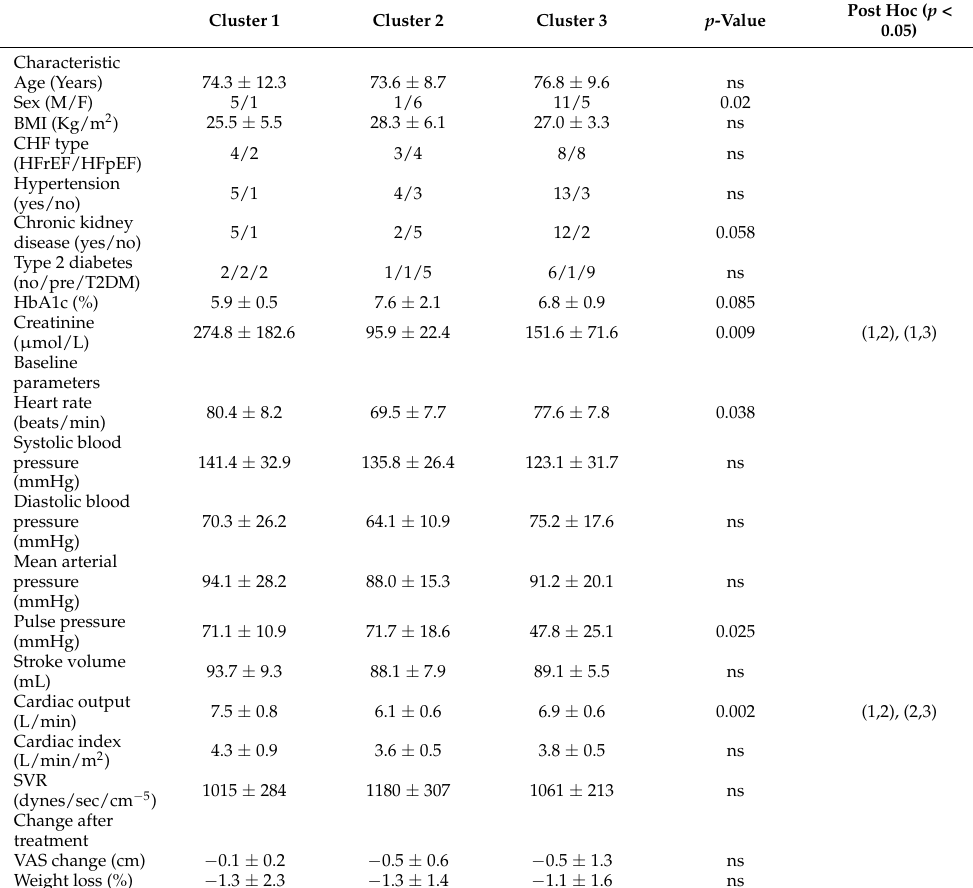
Table 2. Baseline characteristics between clusters (Ratios or mean ± SD). SVR—systemic vascular resistance; BMI—body mass index; SpO 2 —blood oxygen saturation; ns—not significant; HFrEF— heart failure with reduced ejection fraction; HFpEF—heart failure with preserved ejection fraction; T2DM—type 2 diabetes mellitus; VAS—visual analog scale. Cluster 1 Cluster 2 Cluster 3 p -Value Post Hoc (